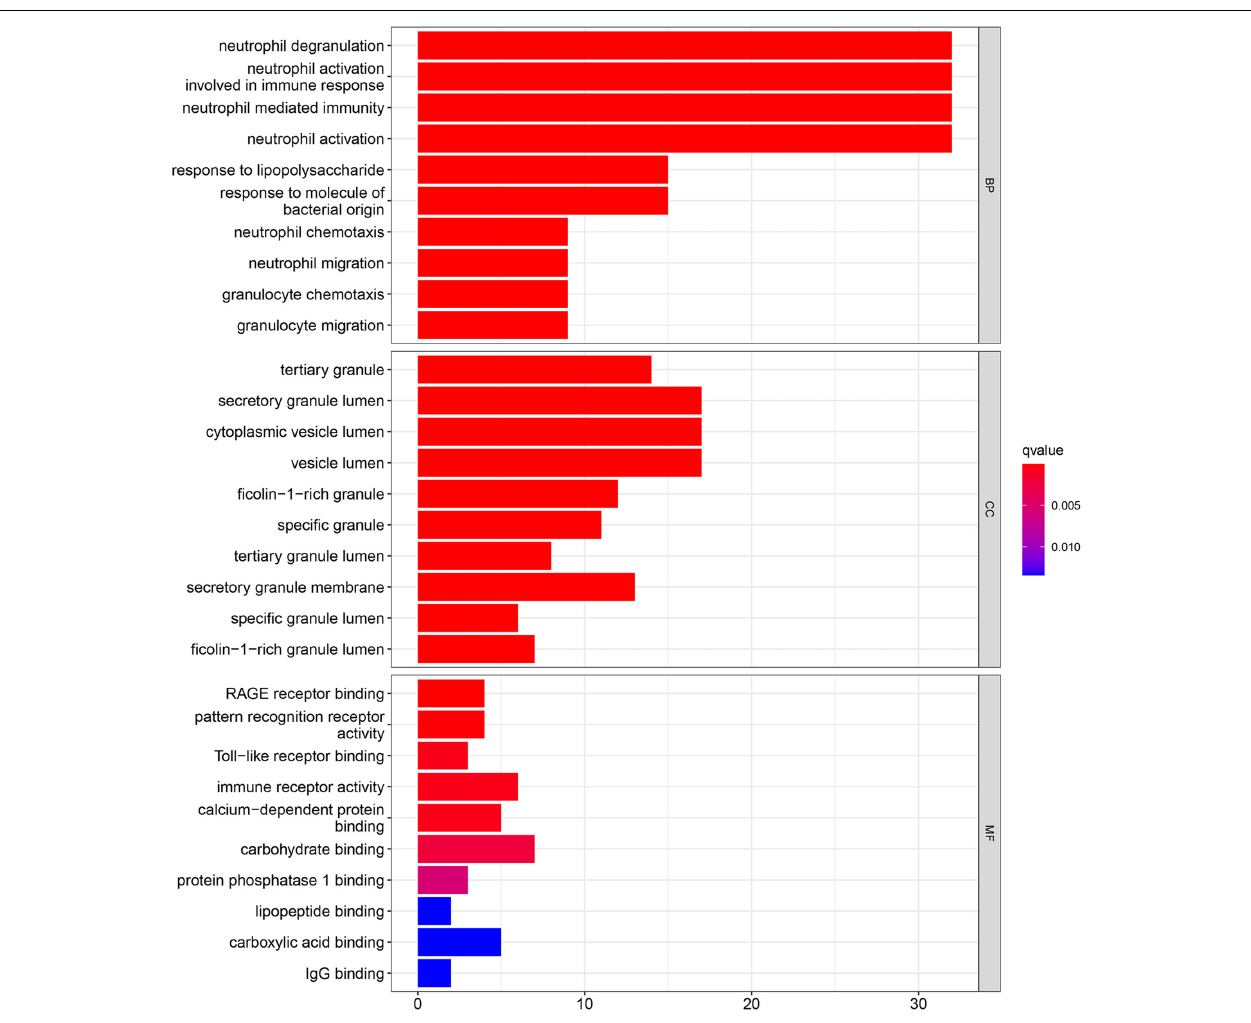
FIGURE 3 | Gene ontology (GO) enrichment analyses of DEGs in acute myocardial infarction (AMI).